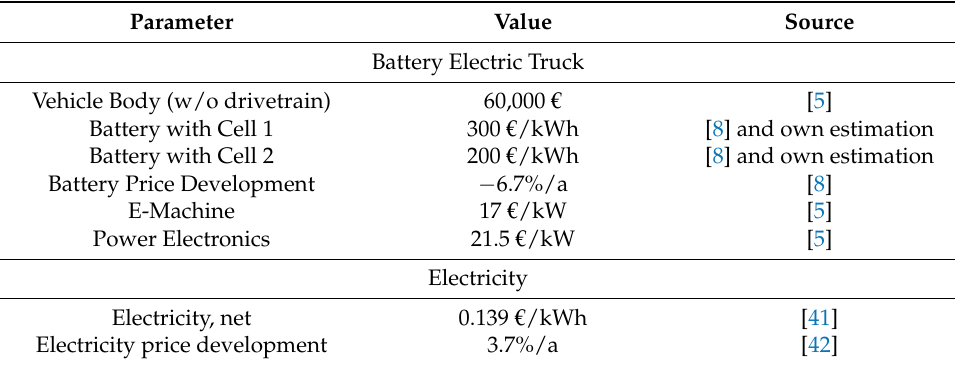
Table A1. Costs parameters for battery electric trucks and electricity used in LCC calculation.